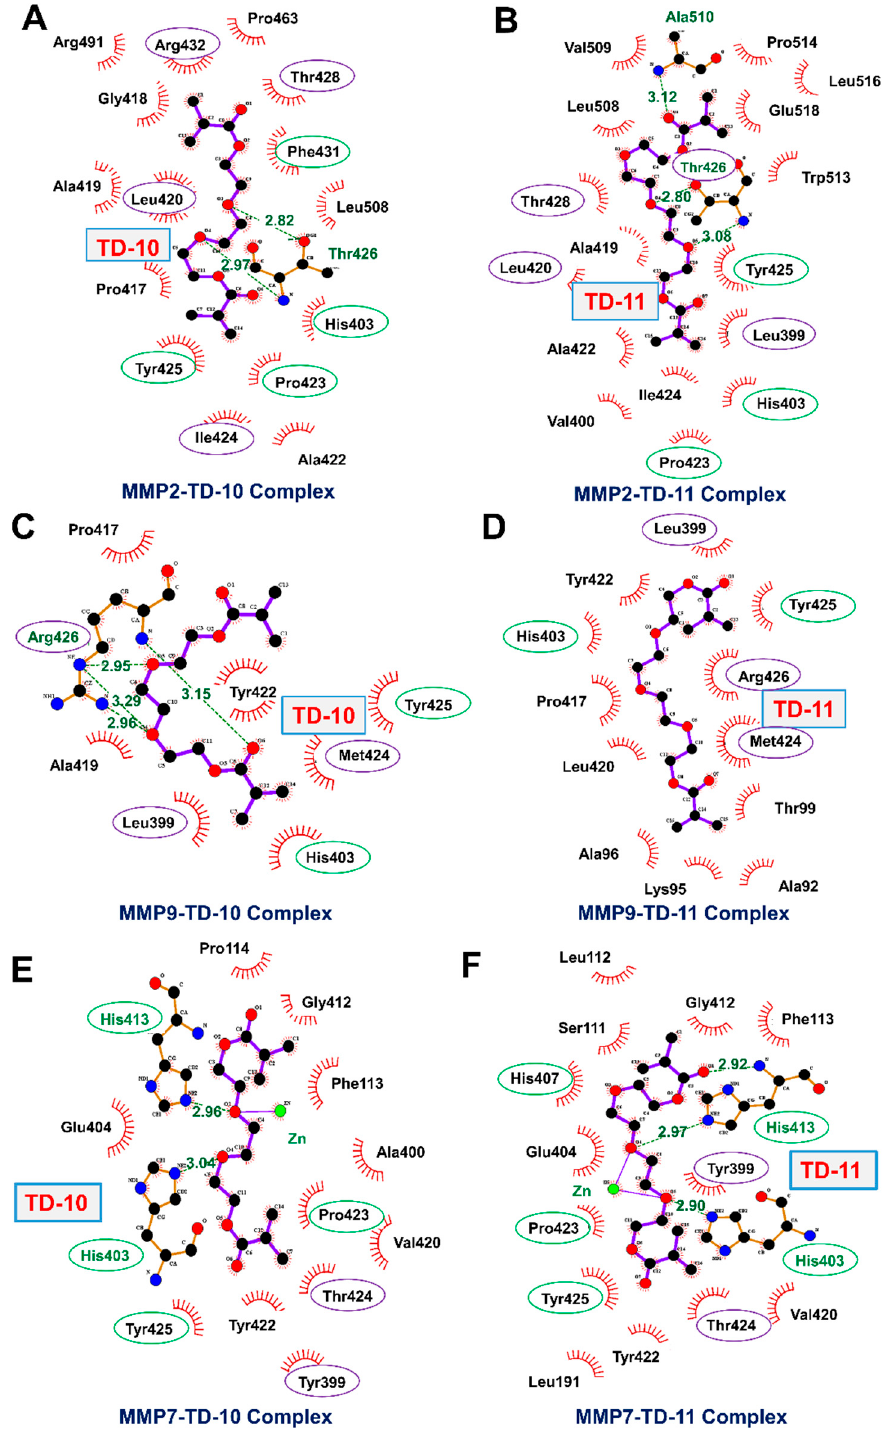
Figure 6. Diagram showing interactions formed by TD-10 and TD-11 with S1’ pocket of MMP-2 ( A , B ), MMP-9 ( C , D ) and MMP-7 ( E , F ), respectively. S1’ pocket residues are highlighted with purple color circle, and conserved residues are highlighted with green circles (residues naming has been done corresponding to MMP-2 protein structure (1CK7)).